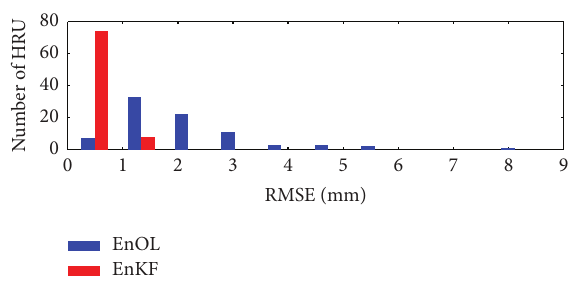
Figure6:TheRMSE(15)distributionoftheestimatedsurfacerunoff ) for 82 HRUs using EnKF and storage ( 𝑄 stor